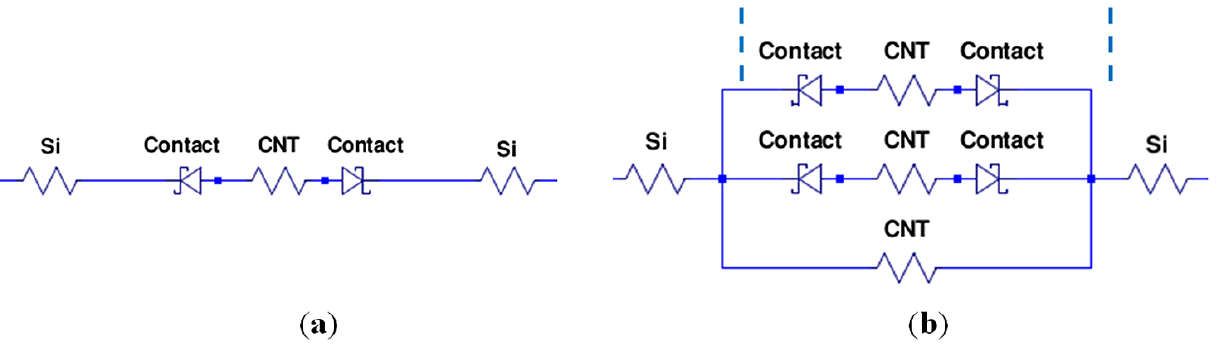
Figure 9. I-V curves from the electrical model compared to measured values.